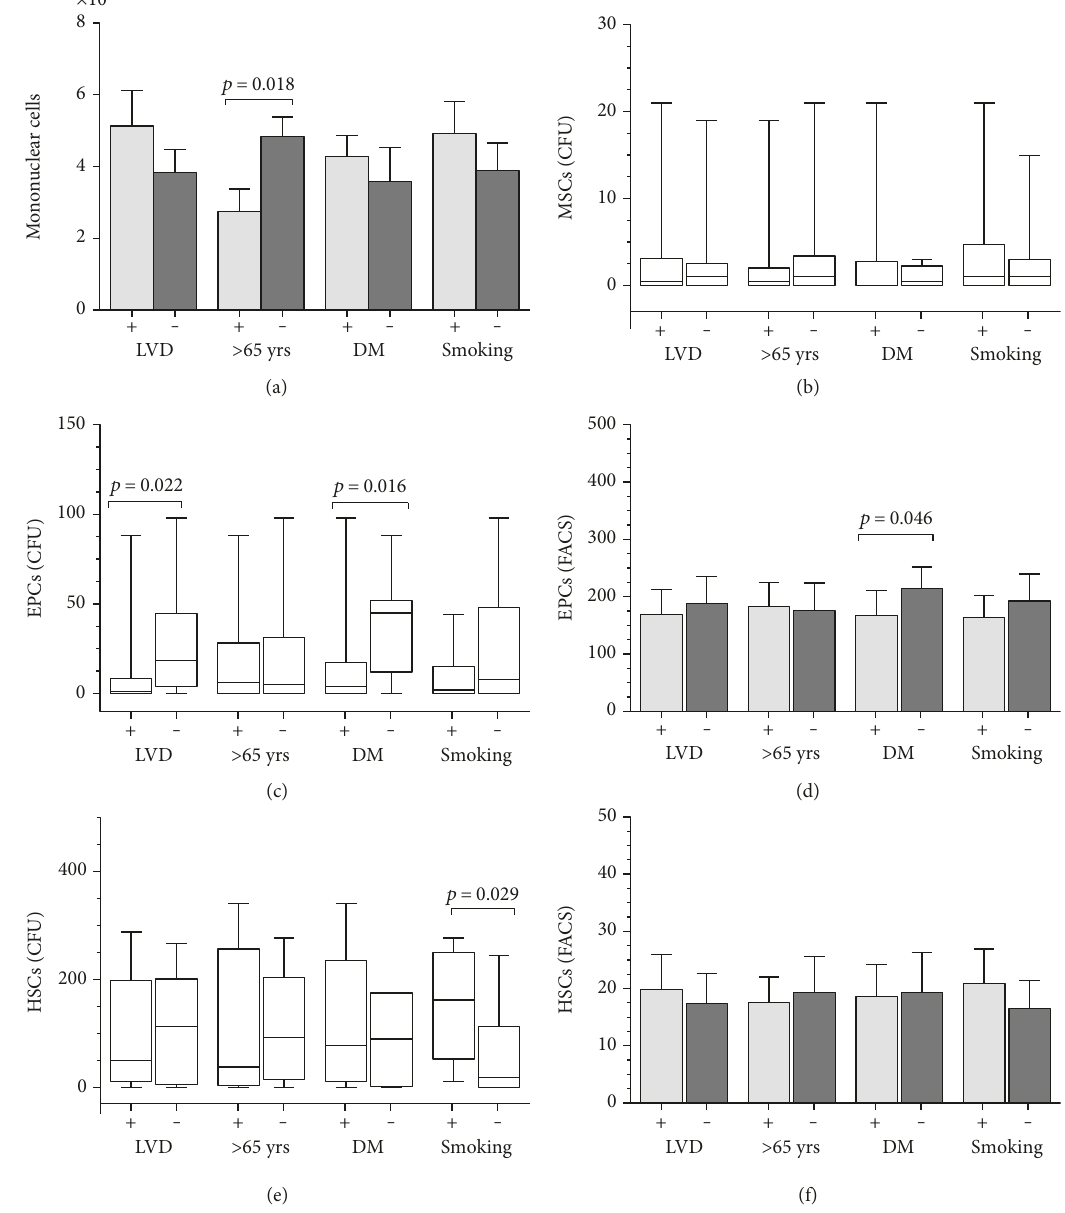
Figure 6: E ff ect of LV dysfunction (LVD) and cardiovascular risk factors (age over 65 years, diabetes mellitus, and smoking) on bone marrow stem cell compartments. (a) Number of mononuclear cells isolated from the sternal bone marrow. Results of clonogenic assay (CFU) and fl ow cytometry analyses (FACS) of mesenchymal stem cells (MSCs, (b)), endothelial progenitor cells (EPCs, (c), (d)), and hematopoietic stem cells (HSCs, (e), (f)). Student ’ s t -test and Mann – Whitney test. DM: Diabetes mellitus. + or − : presence or